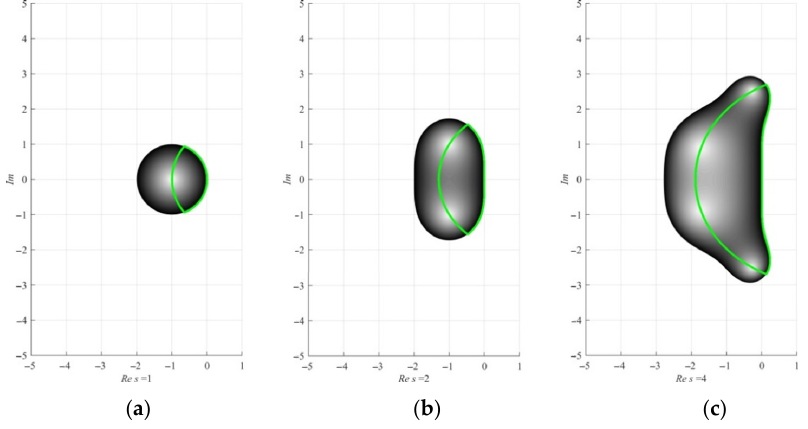
Figure 3. Stability and preference regions of explicit RK1 ( a ), RK2 ( b ), RK4 ( c ) methods. Grayscale shapes denote stability regions and light green lines outline preference regions. Darker shades correspond to the greater absolute value of |eig (𝑅)| .